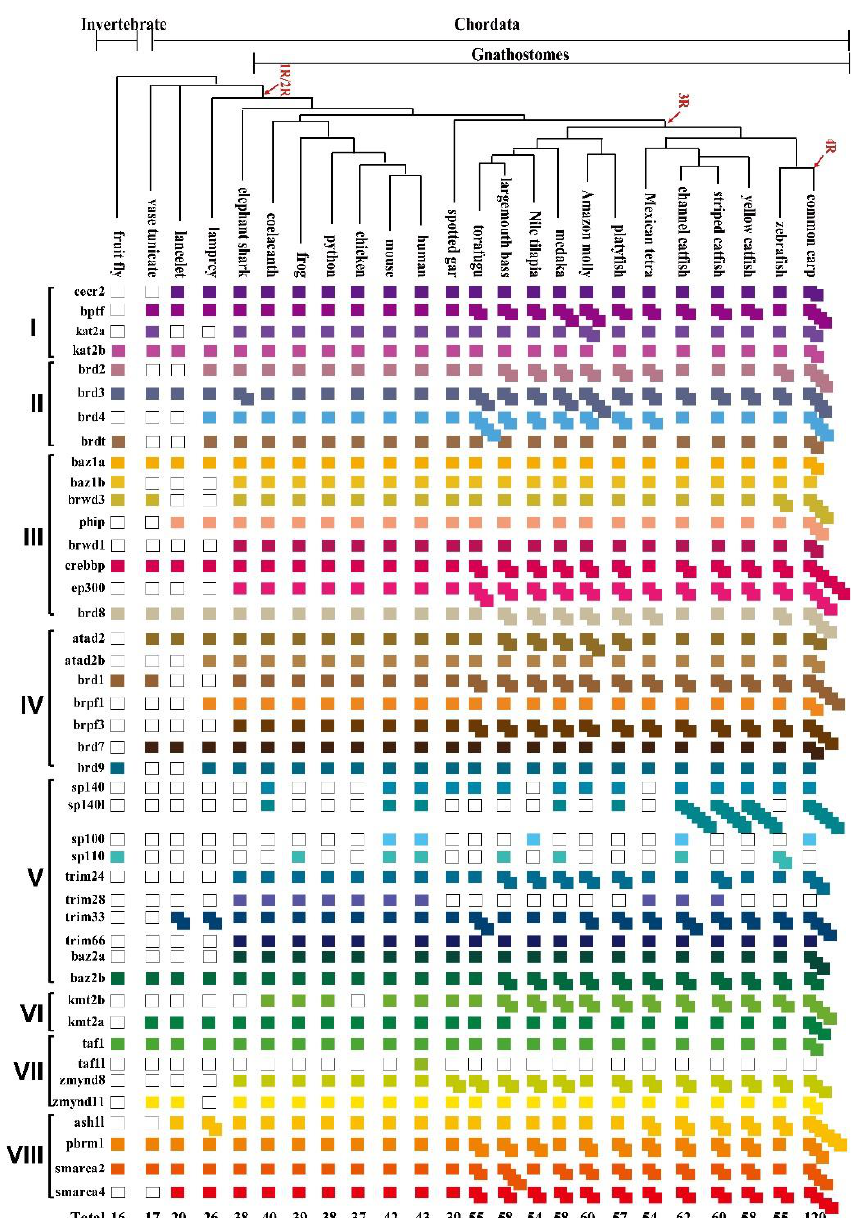
Figure 1. Phylogenetic relationship and numbers of BRD family members identified in 24 representative animals. The four rounds of whole genome duplication (WGD) are represented by 1R, 2R, 3R, and 4R, respectively. The fruit fly, Drosophila melanogaster ; vase tunicate, Ciona intestinalis ; lancelet, Branchiostoma belcheri ; lamprey, Petromyzon marinus ; elephant shark, Callorhinchus milii ; coelacanth, Latimeria chalumnae ; python, Python bivittatus ; frog, Xenopus tropicalis ; chicken, Gallus gallus ; mouse, Mus musculus ; human, Homo sapiens ; spotted gar, Lepisosteus oculatus ; torafugu, Takifugu rubripes ; largemouth bass, Micropterus salmoides ; Nile tilapia, Oreochromis niloticus ; medaka, Oryzias latipes ; Amazon molly, Poecilia formosa ; Southern platyfish, Xiphophorus maculatus ; Mexican tetra, Astyanax mexicanus ; channel catfish, Ictalurus punctatus ; striped catfish, Pangasianodon hypophthalmus ; yellow catfish, Tachysurus fulvidraco ; zebrafish, Danio rerio ; and common carp, Cyprinus carpio .